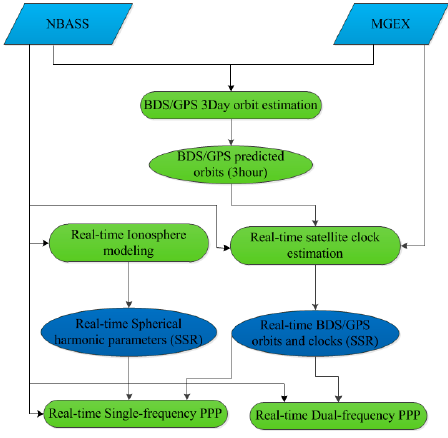
Figure 3. Real-time PPP strategy in NBASS. Table 1. Observation models involved in BDS/GPS POD and clock estimation.